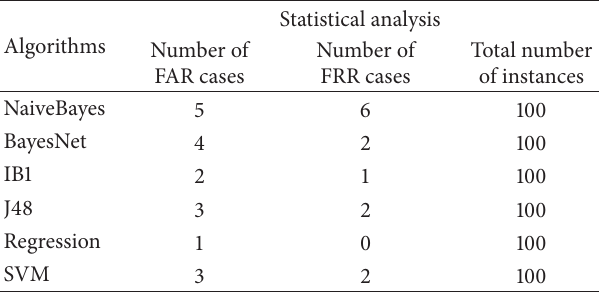
Table 3: The statistical analysis of the FAR and FRR number of cases in the new test case